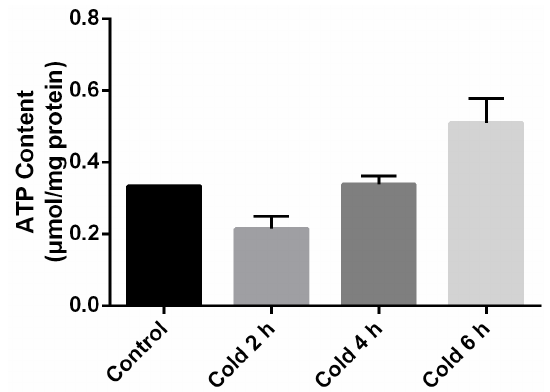
Figure 3. Effect of acute cold stress on the levels of adenosine triphosphate (ATP) in the liver. The data are presented as mean ± SEM ( n = 8). Statistically significant differences are indicated.